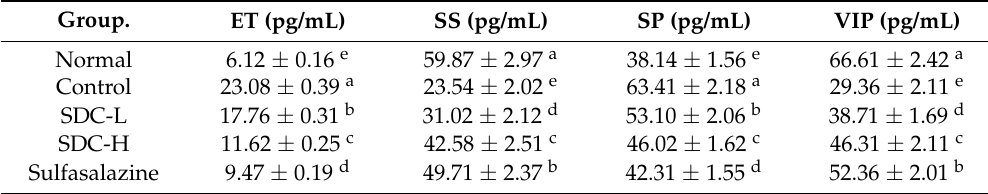
Table 11. Endothelin (ET), somatostatin (SS), substance P (SP), and vasoactive intestinal peptide (VIP) serum levels in mice.